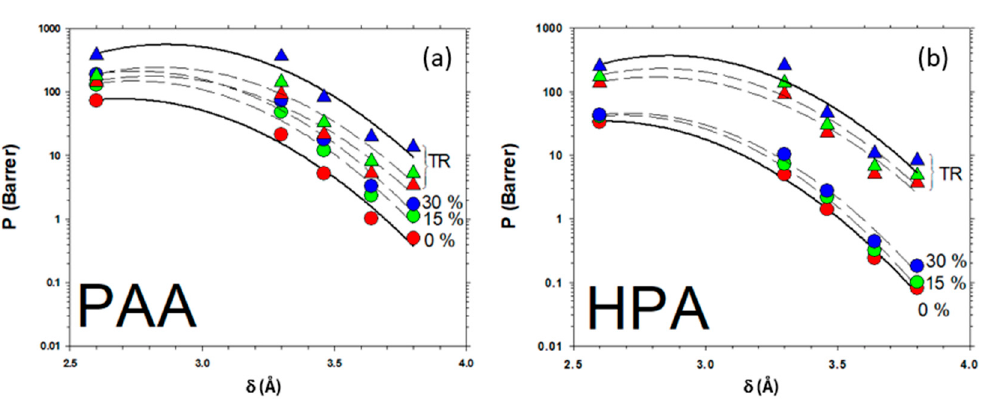
Figure 9. Permeability for the MMMs tested here as a function of the kinematic diameter of the permeated gas. For PAA (a) and (HPA (b). Note that 1 Barrer = 10 − 10 cm3 (STP) · cm/(cm 2 · s · cmHg) = 3.35·10 − 16 mol · m/(m 2 · s · Pa).